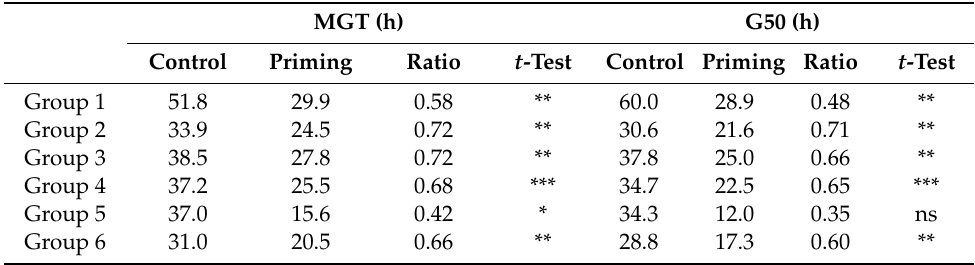
Table 2. E ff ects of priming on mean germination time (MGT) and time to achieve 50% germination (G50) of six genotypic